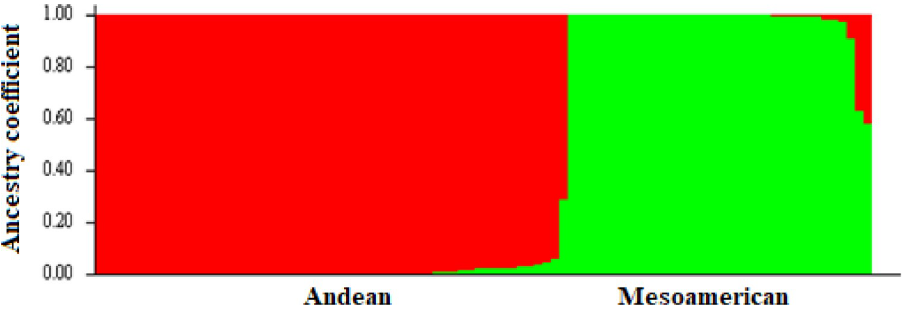
Fig 1. Population structure of 99 common bean genotypes based on SNP markers (K = 2). Red indicates Andean subpopulation and green represent Mesoamerican